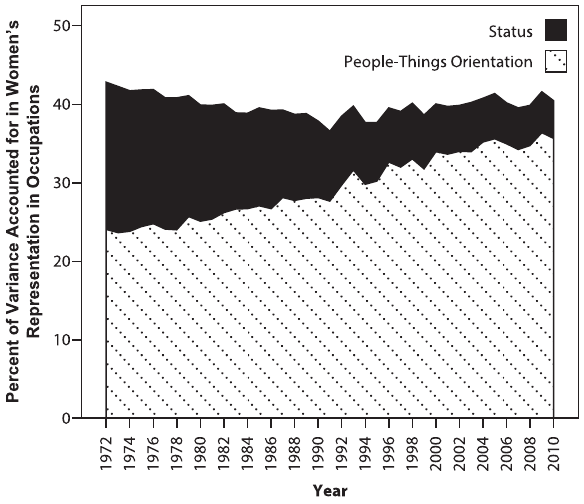
Figure 4. Amount of variance in the percent of women working in occupations accounted for by occupations’ status and people-things orientation for each year from 1972 to 2010.